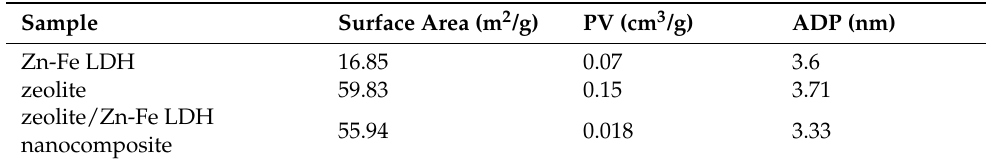
Table 3. The results of BET analyses for the synthesized samples; PV and APD are pore volume and average pore diameters.